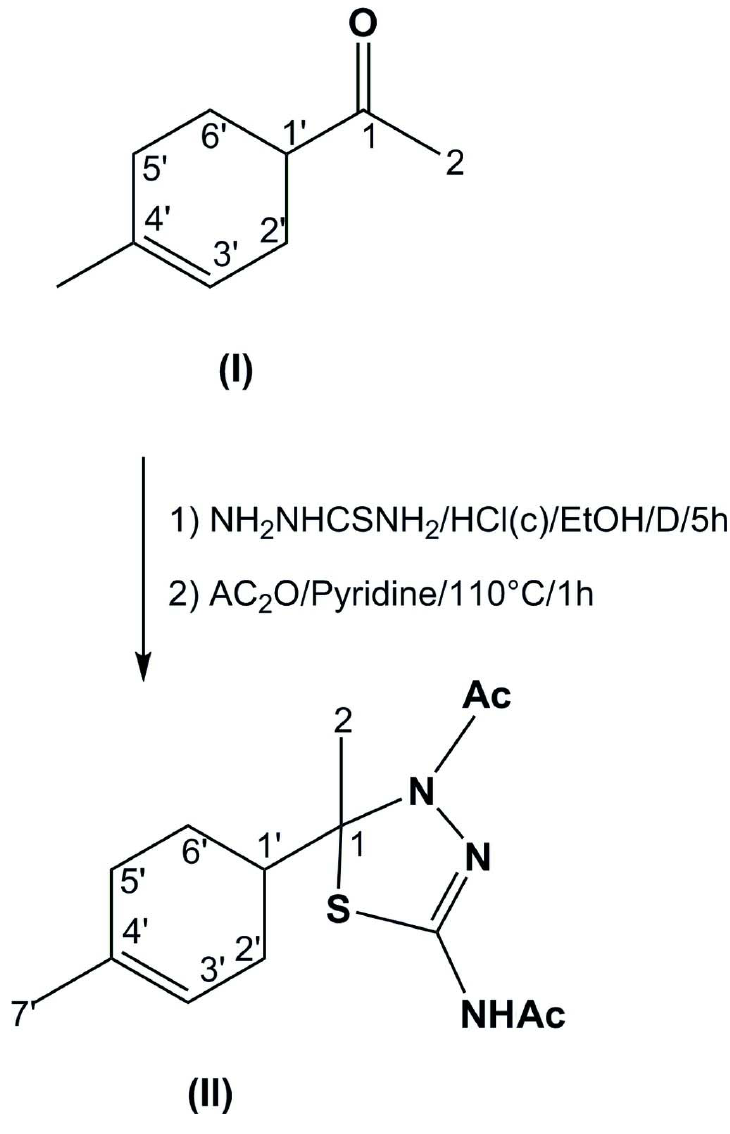
The formation of the title